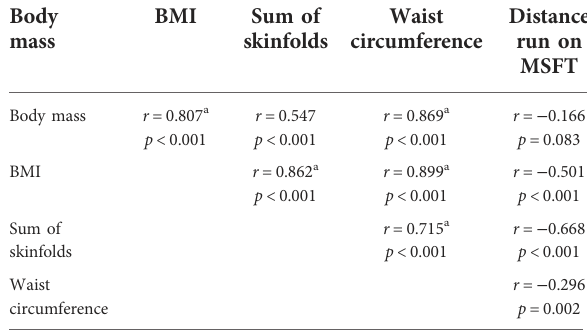
TABLE 2 A correlation matrix to examine collinearity between the independent variables. Body mass